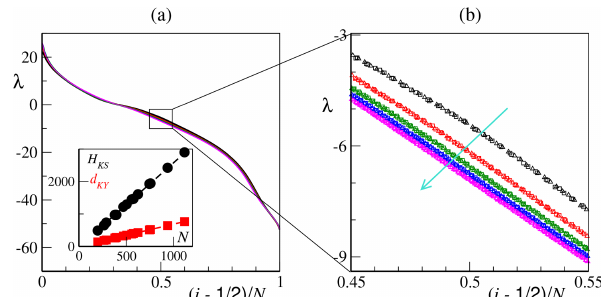
Figure 1. Extensivity of chaos. (a) Lyapunov spectra as functions of the rescaled index i r = (i − 1 / 2 )/N for K = 18, 24 and 36 and J = 10, 15, 20, 25 and 30 (all possible combinations). (b) Details of the central region i r ∈ ( 0 . 45 , 0 . 55 ) . The cyan arrow marks the direction of increasing J values, while each J branch is the superposition of the spectra for K = 18 (circles), K = 24 (squares) and K = 36 (tri- angles). Inset of panel (a) : Kolmogorov–Sinai entropy H KS (black circles) and Kaplan–Yorke dimension d KY (red squares) as a func- tion of the number of degrees of freedom N = K(J + 1 ) . The dashed lines mark a linear fit with zero intercept and slope ≈ 2 . 6 ( H KS ) and ≈ 0 . 7 ( d KY ). Simulations have been performed with h = 1 and √ b = 10 J (see main